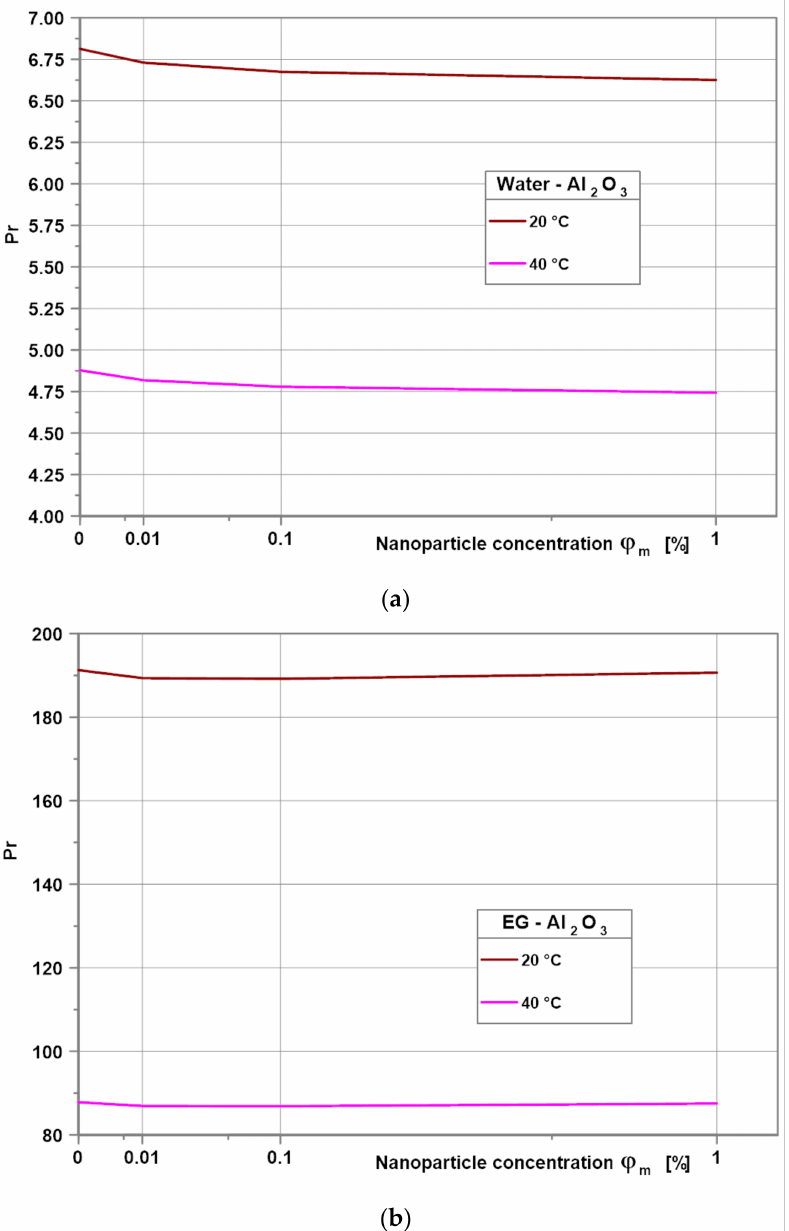
Figure 7. Variation of Pr number with nanoparticle mass concentration for water-based ( a ) and EG-based ( b )